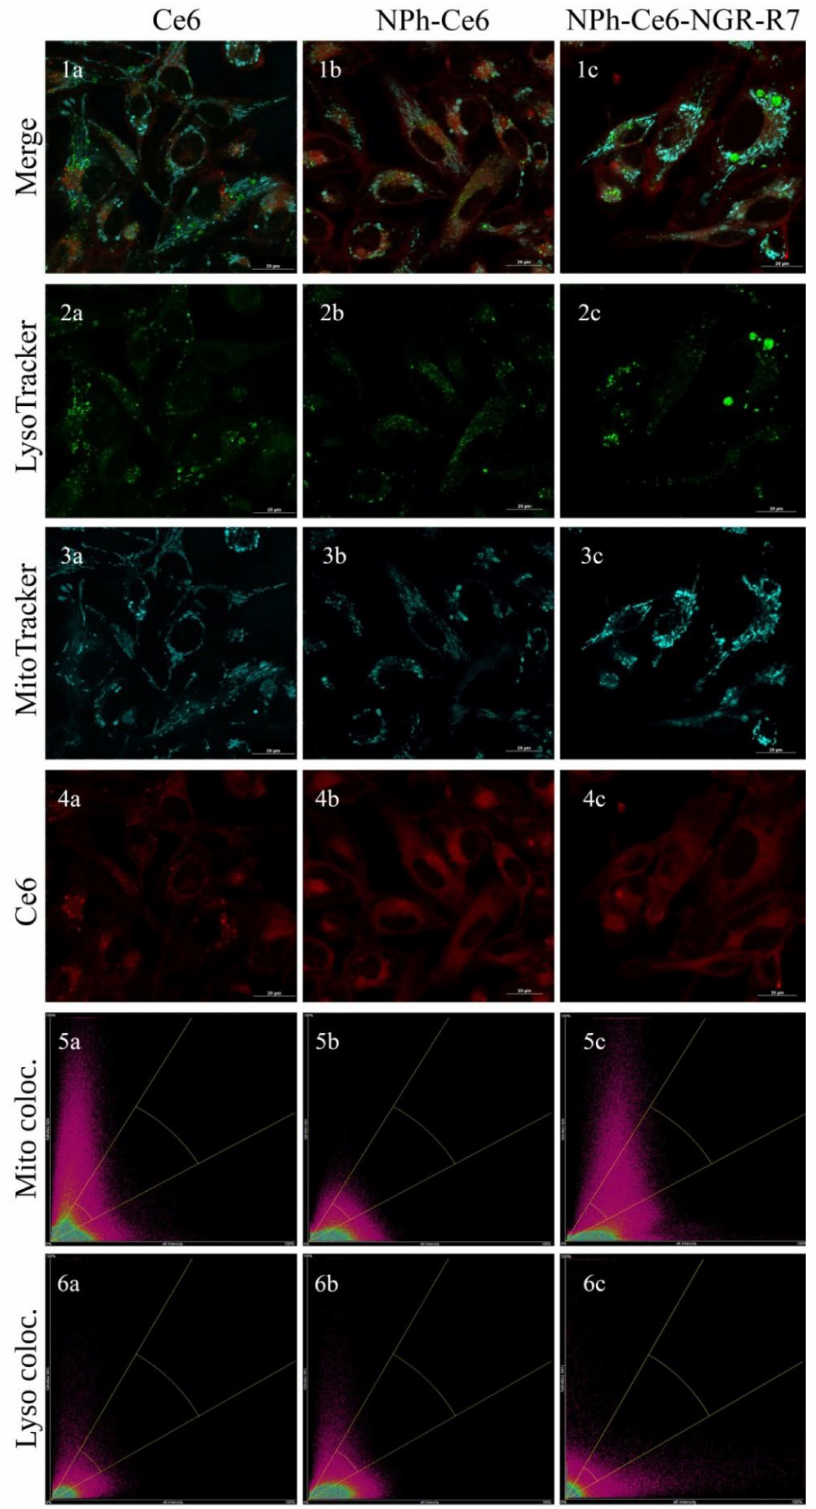
Figure 1. Colocalization analysis of chlorin e6 in the HT-1080 cell line, where: ( a ) Ce6, ( b ) NPh-Ce6, ( c ) NPh-Ce6-NGR-R7 and corresponding channels ( 1 ) Merge image, ( 2 ) LysoTrackerTM Green DND- 26, ( 3 ) MitoTracker™ Red CMXRos, ( 4 ) chlorin e6 compositions, ( 5 ) Mito colocalization, ( 6 ) Lyso colocalization. Scale—20 µ